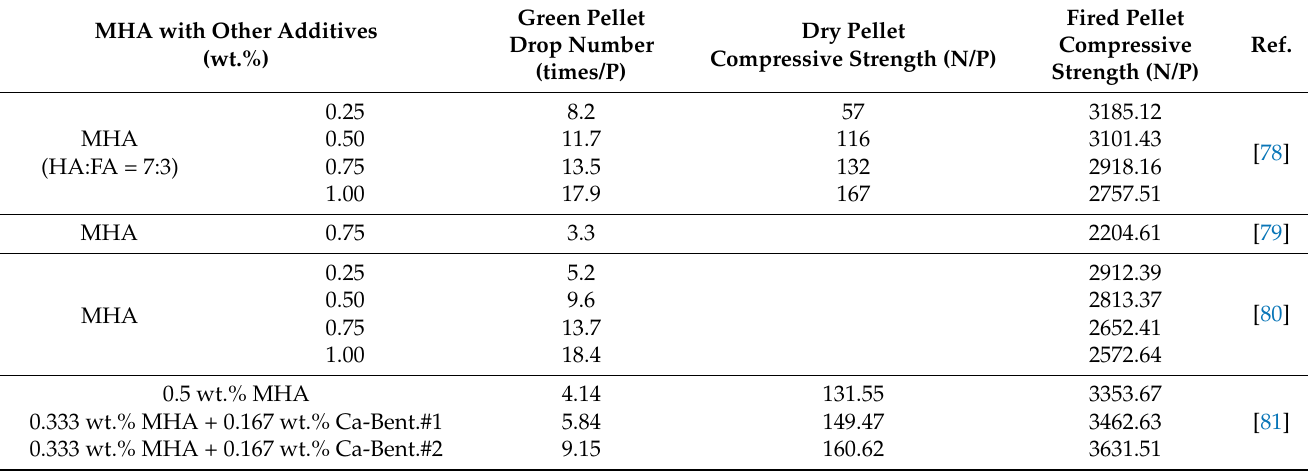
Table 3. The effect of MHA with other additives on the performance of